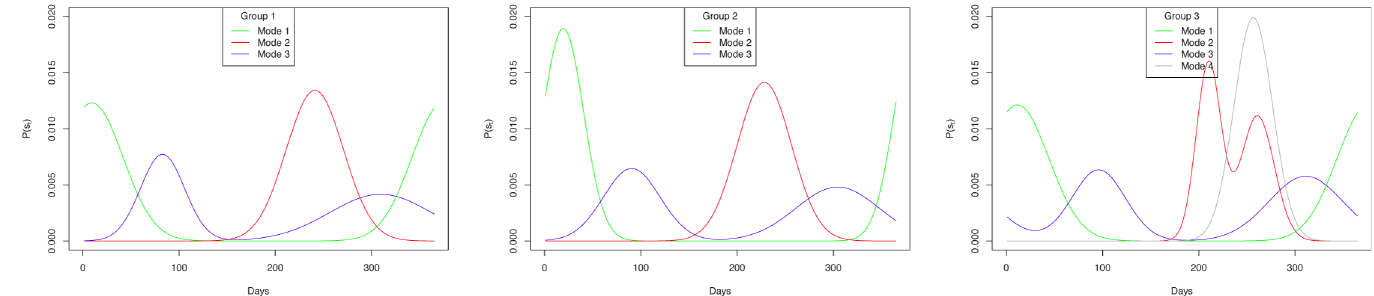
Fig 7. Results of fitting the temporal models. Each curve represents the probability of a particular day being in a specific transhumance mode. The horizontal axis indicates the days in a year starting on August